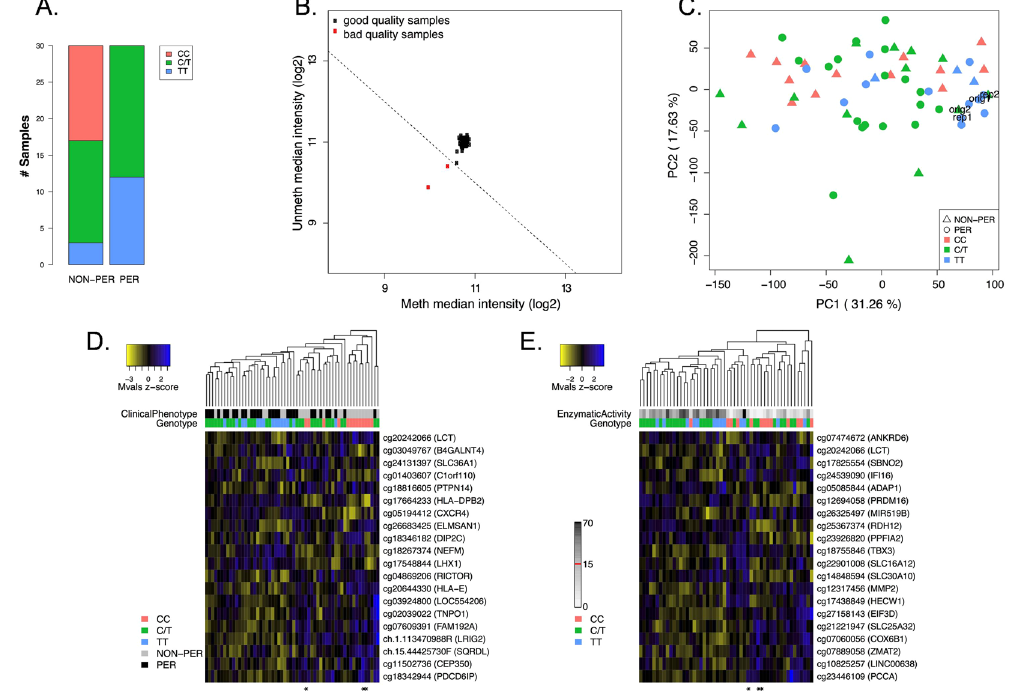
Figure 2. Genome-wide DNA methylation analysis of lactase persistent and non-persistent individuals. ( A ) Composition of samples included on the 450K DNA methylation array. The number of samples in each group, non-persistent (NON-PER) and persistent (PER), is given according to their genotype at − 13910C > T (rs4988235). ( B) Outlier prediction following background correction, dye-bias normalization and filtering: all probes with a detection value p > 0.01 in at least 10% of the data; probes with bead count ≤ 3; and probes with known SNPs. ( C ) PCA plot of DNA methylation variation at all CpGs, excluding CpGs on sex chromosomes (X and Y) after batch correction using ComBat. ( D – E) Colorspace corresponds to methylation levels as z-score transformed M-values (yellow = hypo-, blue = hypermethylation). ( D) Top 20 DMPs identified following ordinal regression of genotype (CC = 0, C/T = 1, TT = 2); ( E) Top 20 DMPs identified from ordinal regression analysis using quartiles of enzymatic activity levels (q1 = [0, 6.8], q2 = [6.8, 14.8], q3 = [14.8, 28.6], q4 = [28.6, 73.7]). Both analyses were adjusted for sex, age and estimated surrogate variables. Nearest gene of the DMPs is displayed in parenthesis. A * designates the three self-reported lactose-intolerant individuals (all CC